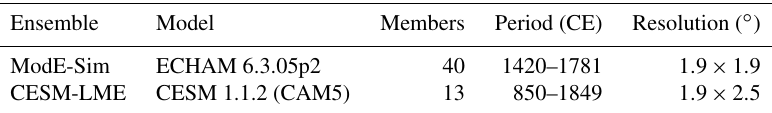
Table 1. List with information concerning the model ensembles employed to generate the background state of the atmosphere. From left to right are the ensemble and model names, the number of members, the pre-industrial time period with available information, and the spatial resolution in decimal